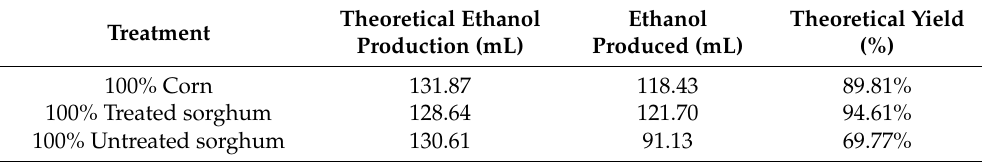
Table 6. Average theoretical yield of sorghum fermentations with cellulase.